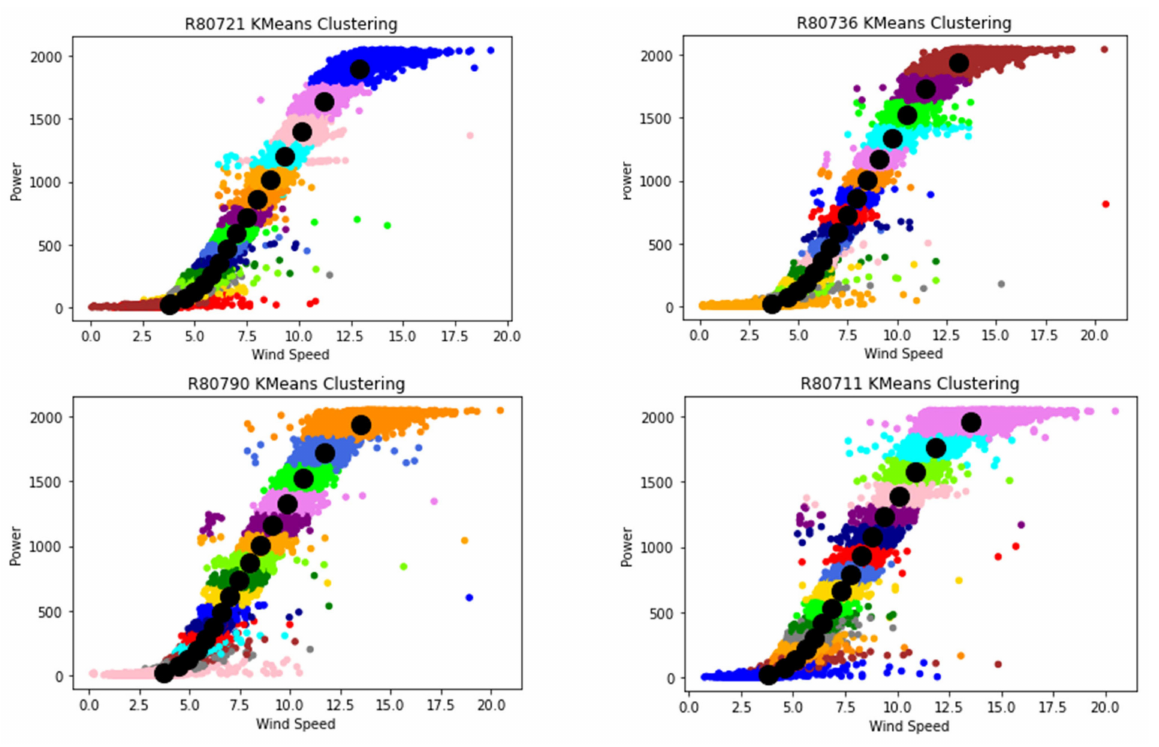
Figure 12. K-Means Clustering of Each